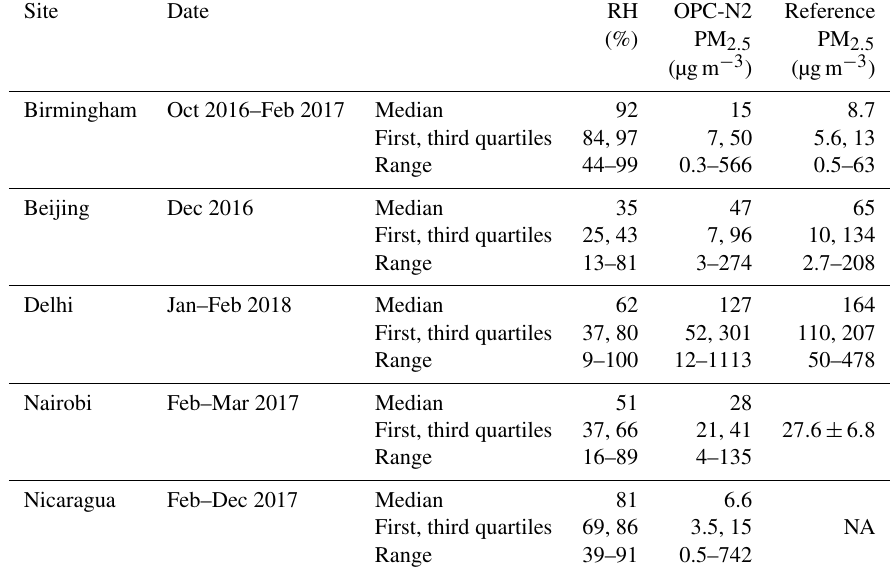
Table 2. Summary of measurement datasets. Reported OPC-N2 PM 2 . 5 mass concentrations are uncorrected. For the Nicaragua measure- ments, there was no co-located reference instrumentation. Only one 24h average gravimetric PM 2 . 5 concentration was available for Nairobi, which is presented with the stated measurement